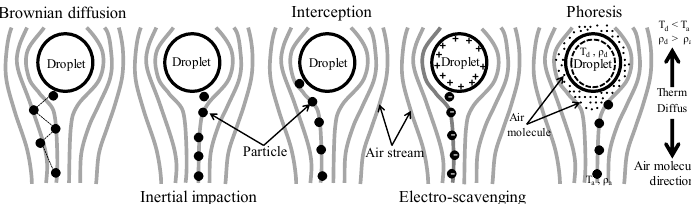
Figure 1. Mechanisms that affect the collection process of aerosol particles by water droplets. The mechanisms, from left to right, are Brownian diffusion, inertial impaction, interception, electro-scavenging and phoresis. T d and ρ d are the temperature and water molecule density at the droplet surface, while T a and ρ a are the ambient temperature and water molecule density. See text for additional description. Figure based on Ladino